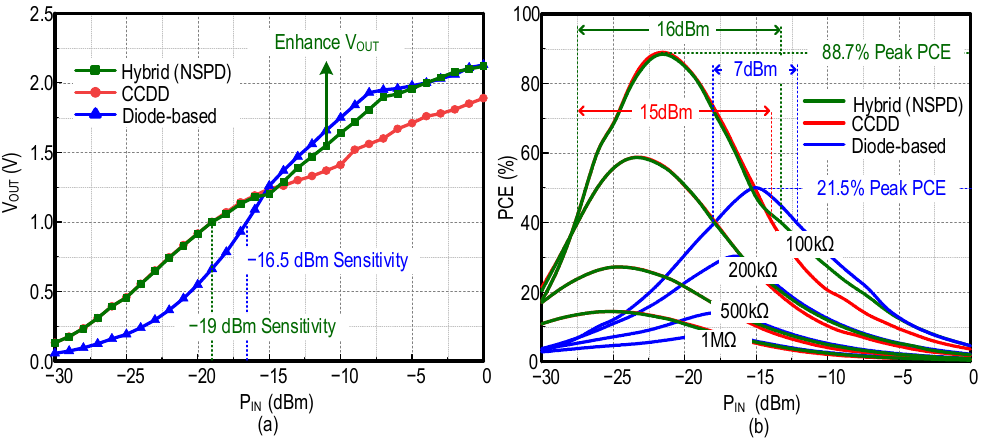
Figure 13. Postlayout simulation of ( a ) rectifier output voltage across different input power at 100 k Ω without matching, ( b ) the power conversion efficiency of rectifiers across different input powers at various load conditions.